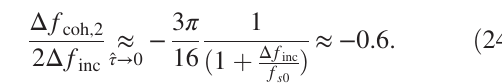
FIG. 10. Contribution of the incoherent shift 2 Δ f Δ f as a function of bunch length, for a pure inductive impedance Im Z =n ¼ 3 Ω (left) and the full SPS impedance (right). The Q26 coh ; 2 optics parameters in Table I were used with N b ¼ 5 × 10 10